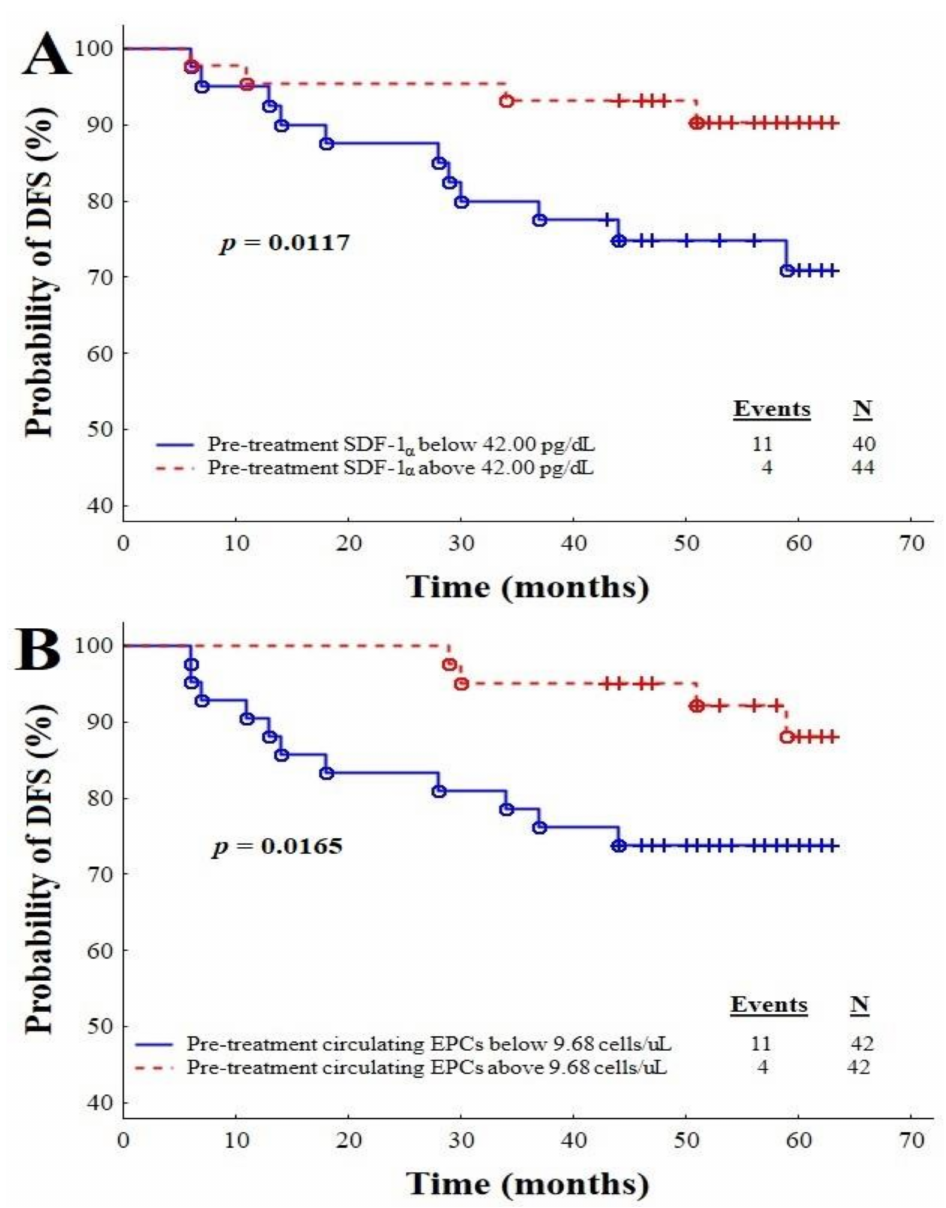
Figure 3. Plots A and B: Kaplan–Meier survival curves showing pre-treatment plasma SDF-1 α ( A ) and the number of circulating EPCs ( B ) in IBrC patients, divided according to cut-offs: for SDF-1 α , <42 pg/dL and >42 pg/dL; circulating EPCs, <9.68 cells/ µ L and > 9.68 cells/ µ L. Additionally, based on the multivariate Cox regression model, we have provided Kaplan–Meier curves for the VEGF-A (Figure 4A), sVEGFR1 (Figure 4B) and sVEGFR2/sVEGFR1 ratio (Figure 4C). A significant difference with respect to the concen- tration of sVEGFR1 was noted (Figure 4). The recurrence of the disease in the group of patients with sVEGFR1 concentrations higher than 29.86 pg/mL occurred in four out of 42 (9.52%), but in the subgroup with sVEGFR1 levels lower than 29.86 pg/mL, 11 out of 42 (26.19%) had recurrence ( p =